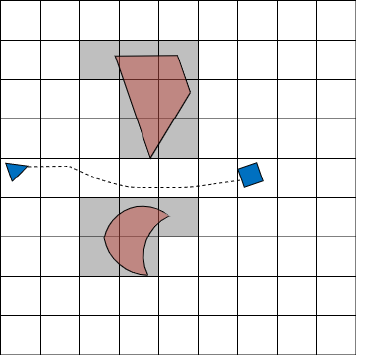
Figure 6. Augmentation of Figure 5 rotated at 71 ◦